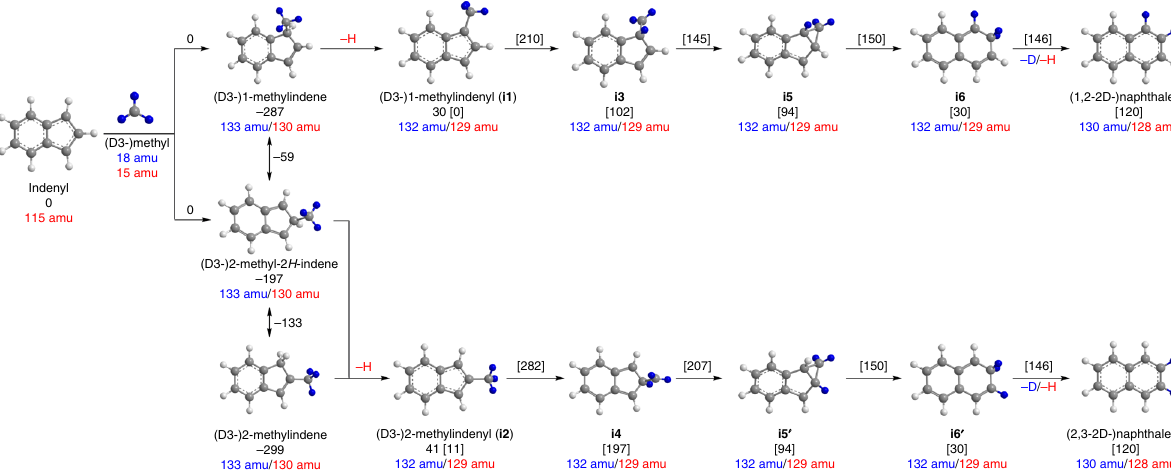
Fig. 1 Reaction pathways for the 1-indenyl — (D3-)methyl systems leading to (D2-)naphthalene with atoms in blue tracing the deuterium atoms. The blue and red numbers indicate the mass-to-charge ratios of the reactants, intermediates, and products in the 1-indenyl/D3-methyl and 1-indenyl/methyl systems, respectively. The energies are de fi ned with respect to the separated reactants; energies in square brackets are de fi ned with respect to the 1- methylindenyl radical; all energies for the (partially) deuterated species are within 1-2 kJ mol − 1 of the non-deuterated counterparts. All energies are given in kJ mol − 1 . The detailed potential energy surfaces and coordinates or reactants, intermediates, and products are compiled in the Supplementary Figs. 1 and 2, and Supplementary Note 2